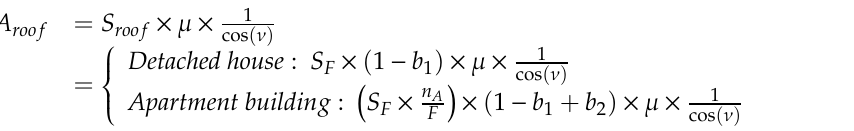
University of Texas at Austin. http://legacy.lib.utexas.edu/maps/topo/vietnam/. Latest access on 20.05.2019.